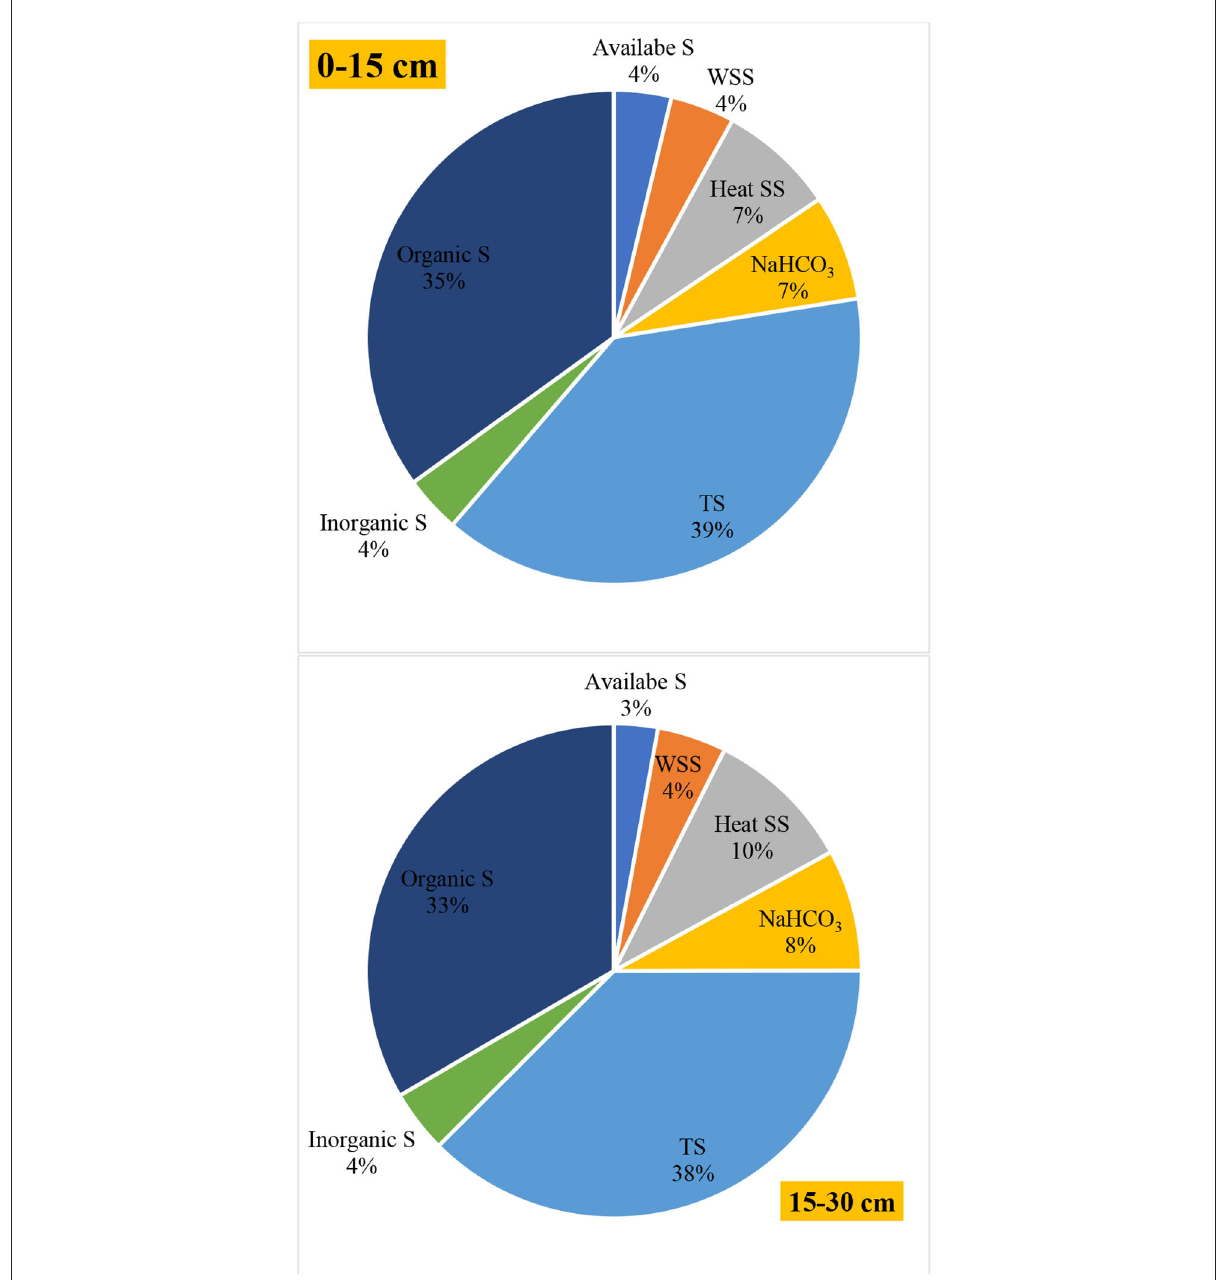
FIGURE6 Effects of long-term nutrient supply on soil sulfur fraction contributions in the 0–15 and 15–30cm soil layers of rice-wheat cropping system (RWCS).